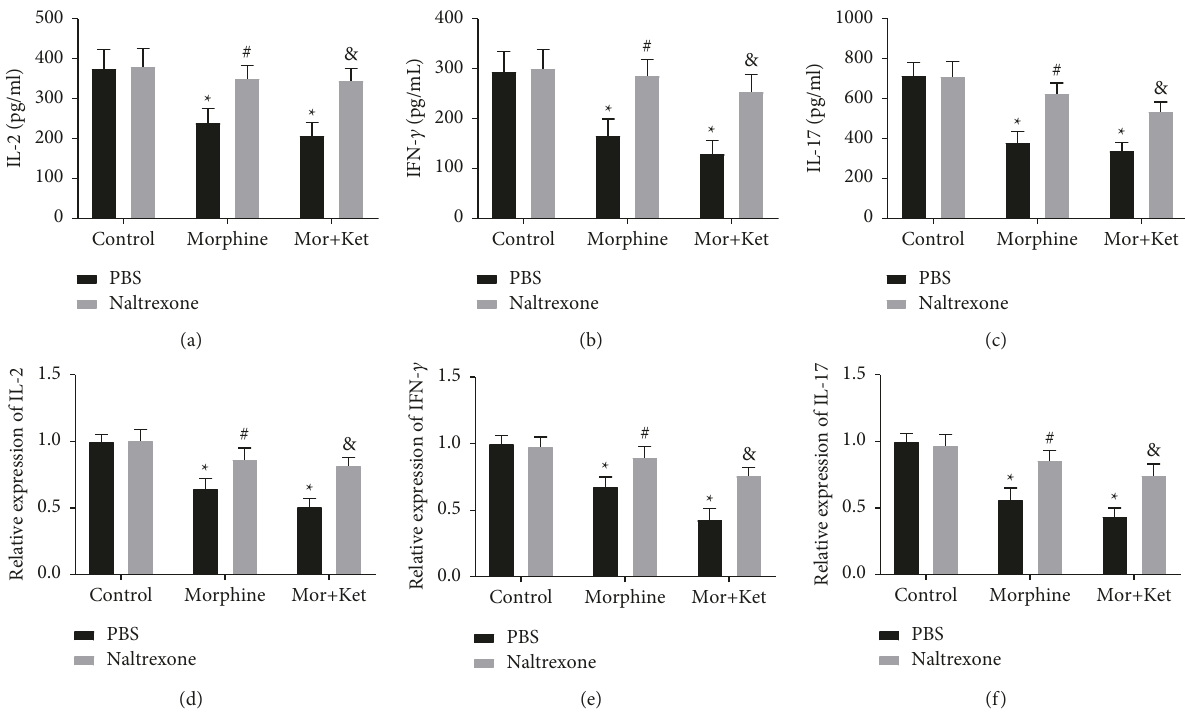
Figure 4: Opioid antagonist naltrexone eliminates the inhibitory effects of morphine and ketamine on IL-2, IFN- c , and IL-17 in vitro. (a) The level of IL-2 after naltrexone treatment measured by ELISA. (b) The level of IFN- c after naltrexone treatment measured by ELISA. (c) The level of IL-17 after naltrexone treatment measured by ELISA. (d) The mRNA expression of IL-2 after naltrexone treatment detected by qRT-PCR. (e) The mRNA expression of IFN- c after naltrexone treatment detected by qRT-PCR. (f) The mRNA expression of IL-17 after naltrexone treatment detected by qRT-PCR. ∗ P < 0 . 05 vs. the control (PBS) group. # P < 0 . 05 vs. the morphine (PBS) group. & P < 0 . 05 vs. the Mor+ Ket (PBS)